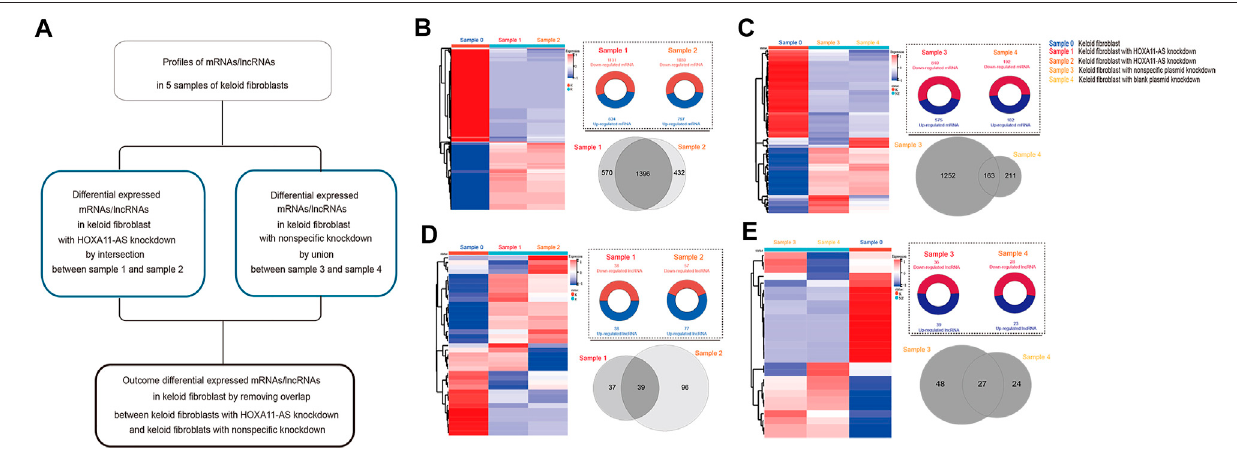
FIGURE 2 | Messenger RNA (mRNA) and long noncoding RNA (lncRNA) expression heatmap and differentially expressed (DE) pro fi les in keloid fi broblasts with HOXA11-ASknockdown stepwise fl owchartforoutcomedifferentiallyexpressed (DE)mRNAs/lncRNAsinkeloid fi broblasts withHOXA11-AS-knockdownwithremoval of nonspeci fi c overlap (A) . Expression heatmap of DE mRNAs in keloid fi broblasts with HOXA11-AS knockdown ( (B) , left). Upregulated and down-regulated pro fi les betweensamples0and1aswellasbetweensamples0and2wereintersectedfortheDEmRNAsinwithHOXA11-ASknockdown( (B) ,right).Expressionheatmap of DE mRNAs in keloid fi broblasts with nonspeci fi c control knockdown ( (C) , left). Both upregulated and down-regulated pro fi les between samples 0 and 1 as well as between samples 0 and 2 were intersected for the DE mRNAs with nonspeci fi c control knockdown ( (C) , right). Expression heatmap of DE lncRNAs in keloid fi broblasts withHOXA11-ASknockdown( (D) ,left).Bothupregulatedanddown-regulatedpro fi lesbetweensamples0and3aswellasbetweensamples0and4wereunitedforDE lncRNAs inwith HOXA11-AS knockdown( (D) ,right).Expressionheatmap ofDE mRNAs inkeloid fi broblasts with nonspeci fi ccontrolknockdown( (E) , left).Upregulated and down-regulated pro fi les between samples 0 and 3 as well as between samples 0 and 4 were united for the DE lncRNAs with nonspeci fi c control knockdown ( (E) ,